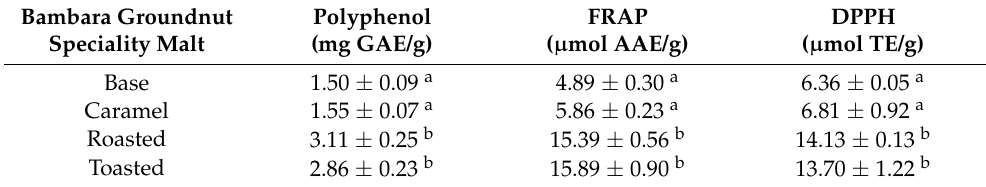
Table 6. Total polyphenols and antioxidant activities of Bambara groundnut speciality malts 1